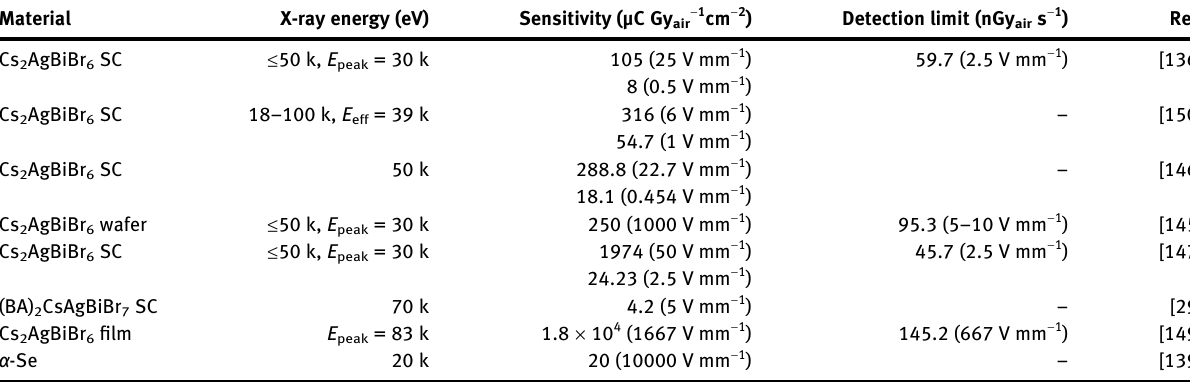
Table  : Summary of fi gure-of-merits of the Bi – Ag double halide perovskite X-ray detector in literature.